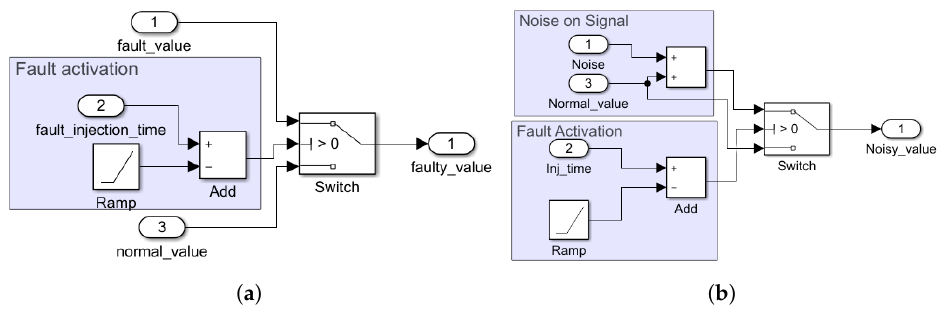
Figure 3. Fault models. ( a ) Fault model of data changing; ( b ) fault model of noise addition.